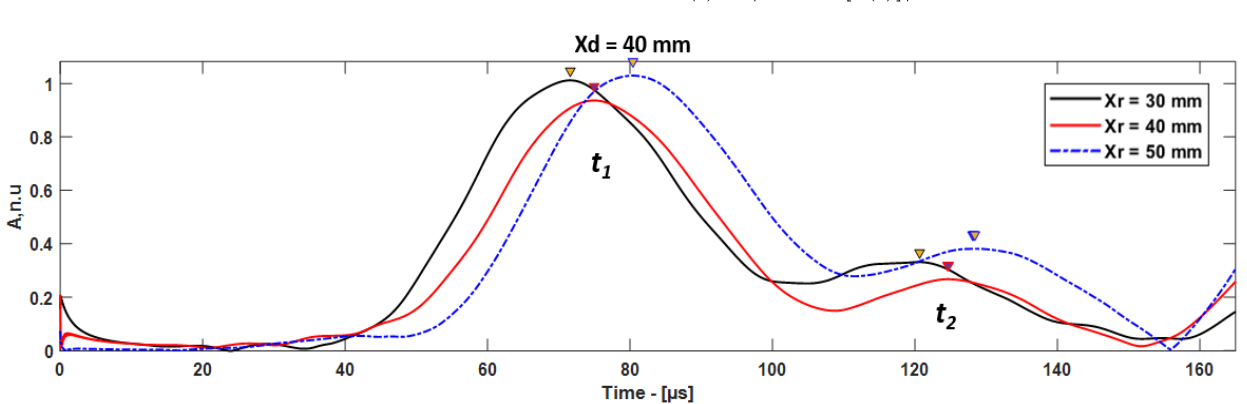
Figure 8. The comparison of time of flight (ToF) of A 0 mode in case of delamination at 40 mm, signals received by different receivers.